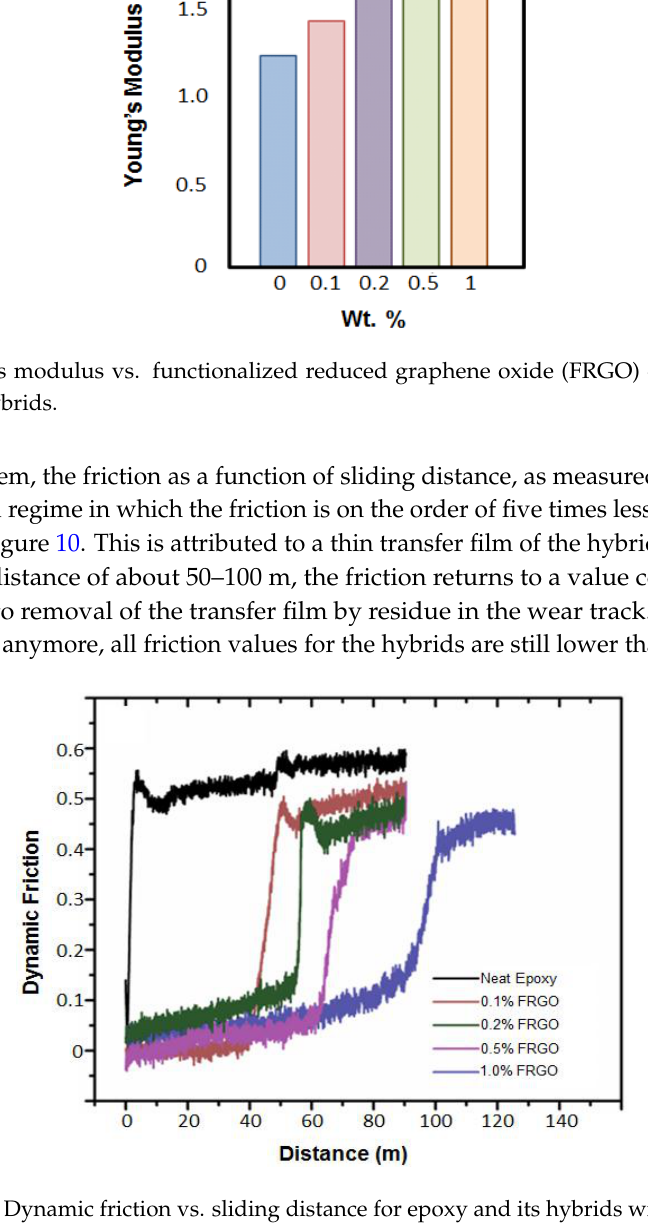
Figure 10. Dynamic friction vs. sliding distance for epoxy and its hybrids with FRGO.